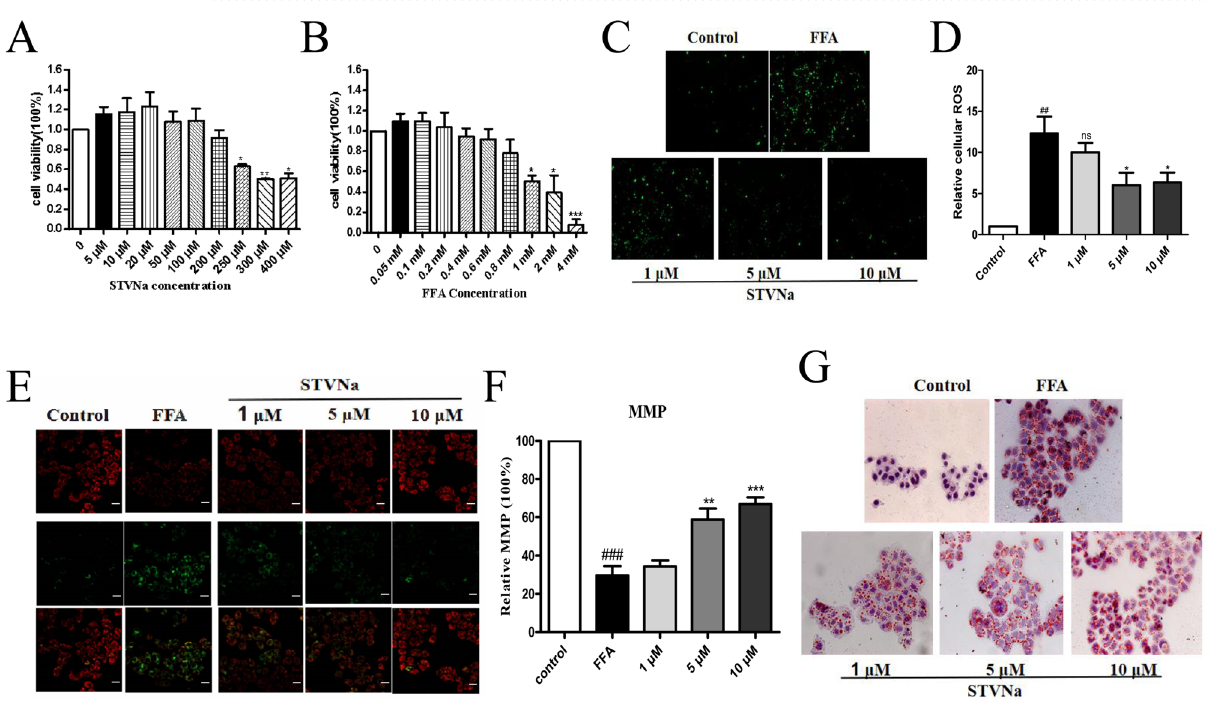
Figure 8. STVNa reduces lipid accumulation in LO2 cells after FFA exposure. ( A , B ) The viability of LO2 cells assessed by CCK-8 assay. ( C ) Fluorescence measurement of ROS levels. Scale bar = 100 μm. ( D ) Graphs showing the changes in ROS levels. ( E ) Representative images of three independent experiments. Fluorescence staining of mitochondrial membrane potential by JC-1 dye. Scale bar = 50 μm. ( F ) Graphs showing the red-to-green (R/G) fluorescence intensities. ( G ) Lipid accumulation in LO2 cells determining by ORO staining. Mean ± SEM. * P < 0.05, ** P < 0.01, *** P < 0.001 vs. FFA-exposed cells; ## P < 0.01, ### P < 0.001 vs. control